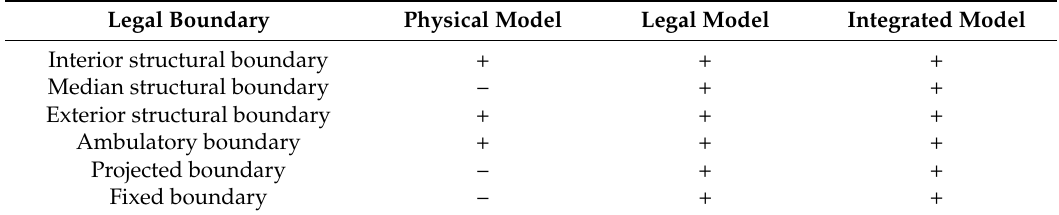
Table 2. Feasibility of modelling legal boundaries in each BIM model (–: not supported, +: supported). Legal Boundary